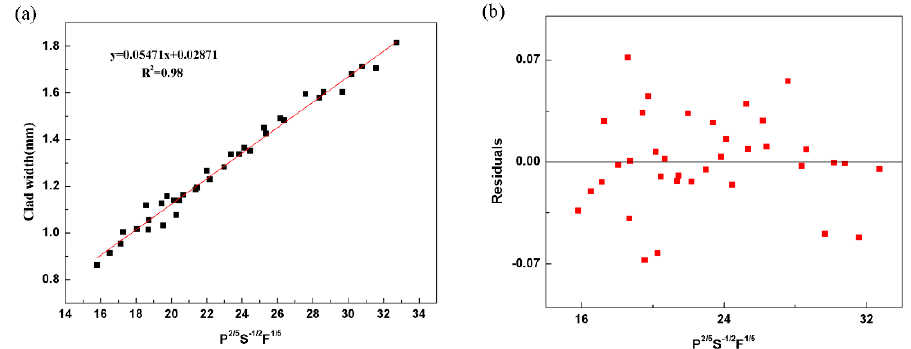
Figure 5. ( a ) The relationship between clad width and the three processing parameters (laser power ( P ), S , and F ). ( b ) Residuals.